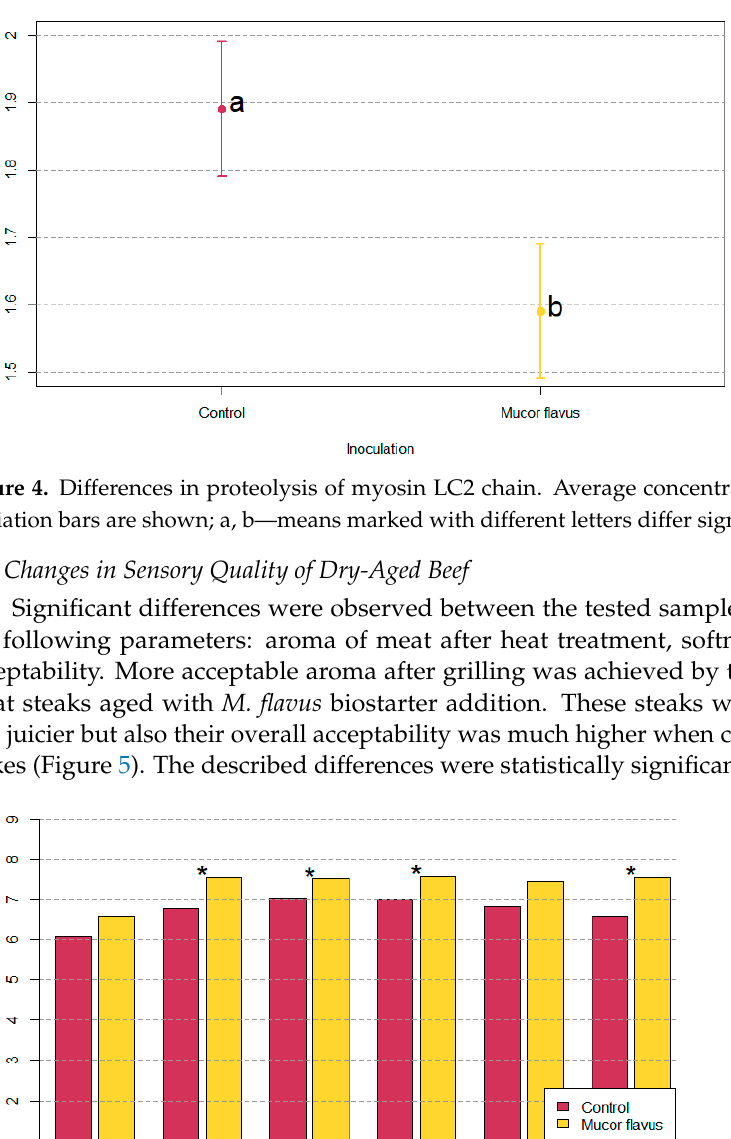
Figure 3. The SDS-PAGE profile of proteins from the aged meat samples; Lane M—marker, Lane 1—control (inside), Lane 2—control (outside), Lane 3—Mf (inside), Lane 4—Mf (outside), Lane 5—